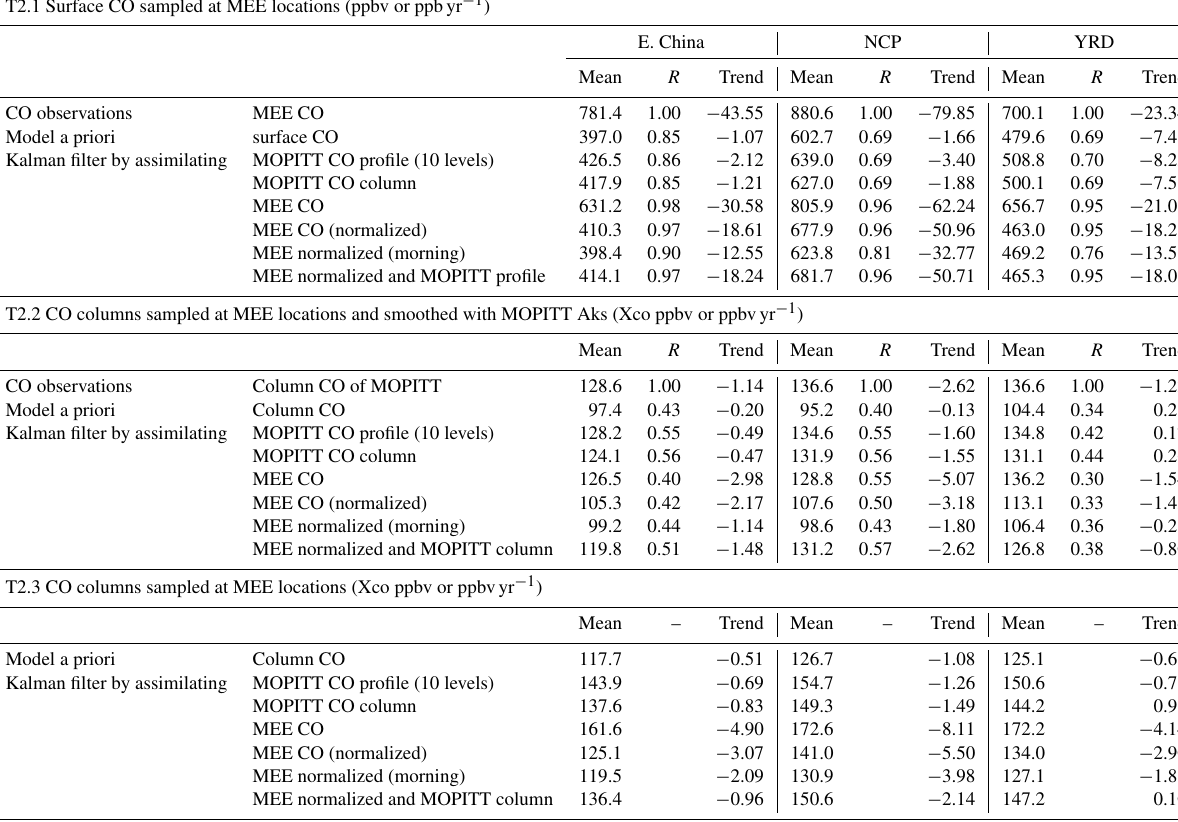
Table 2. Averages, correlations and trends of surface (T 2.1) and column (T 2.2 and T 2.3) CO concentrations in 2015–2020, sampled at the locations of MEE stations. The domain definitions are shown in Fig. 1a. The correlations between simulations and MOPITT observations in T 2.3 are not shown because MOPITT averaging kernels are not